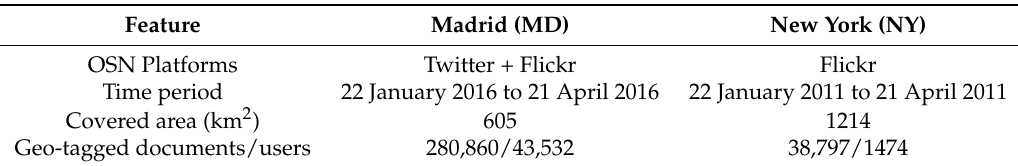
Table 3. Evaluation datasets.